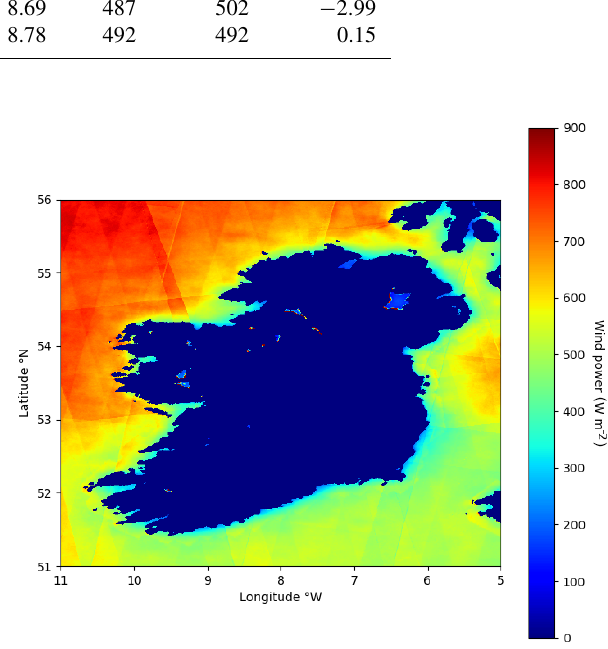
Figure 8. Wind power off Ireland over a 2-year period running from May 2017 to May 2019 retrieved using the Sentinel-1 SAR Level 2 OCN product. Satellite tracks are visible, particularly in the north- east. These are an artefact of the